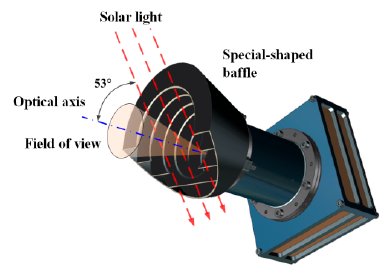
Figure 8. 3D model of special-shaped baffle.